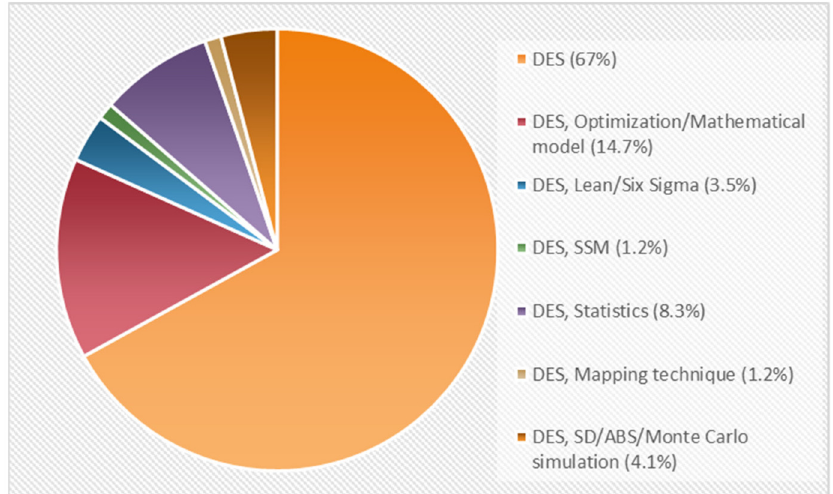
Figure 3. Approaches of applied research